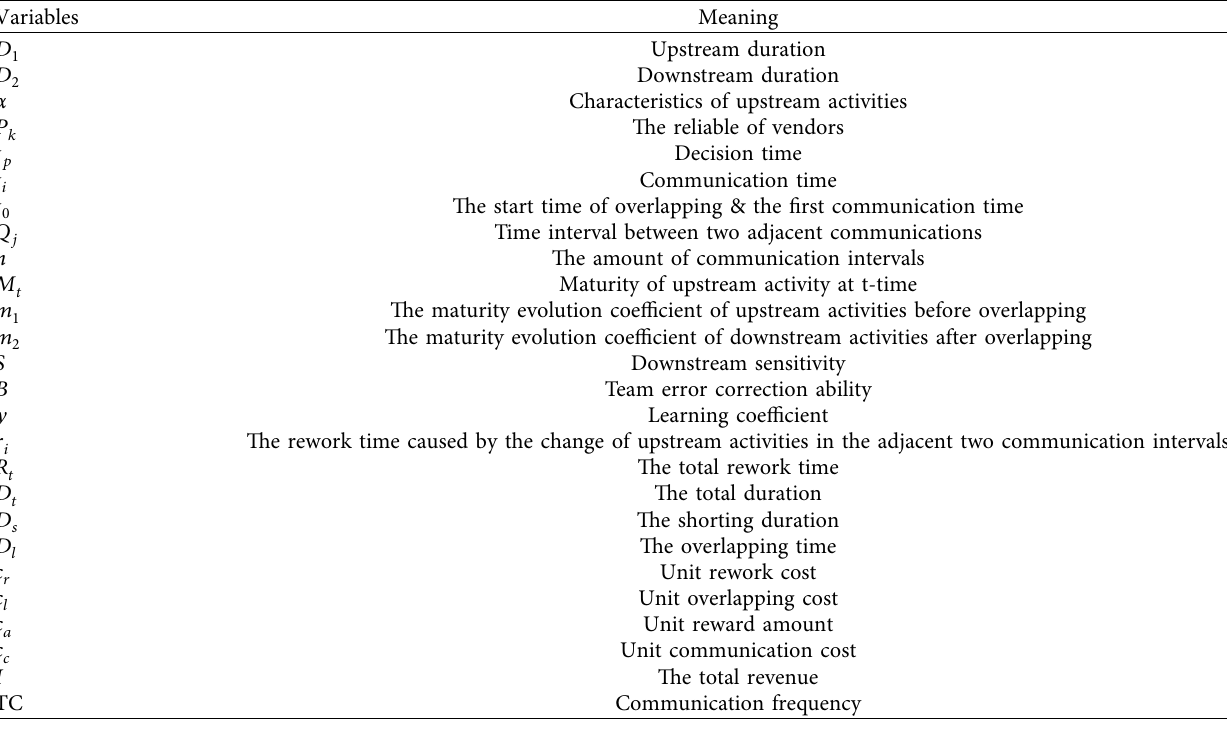
Table 1: List of the main symbols.